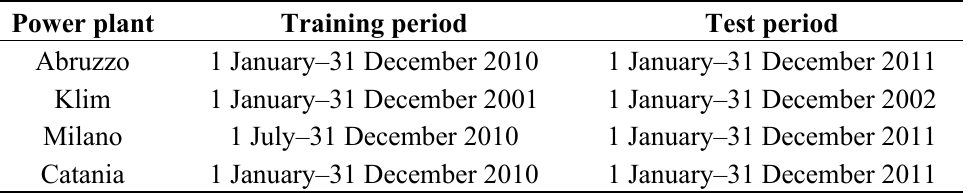
Table 1. Training/test period definitions for the different data